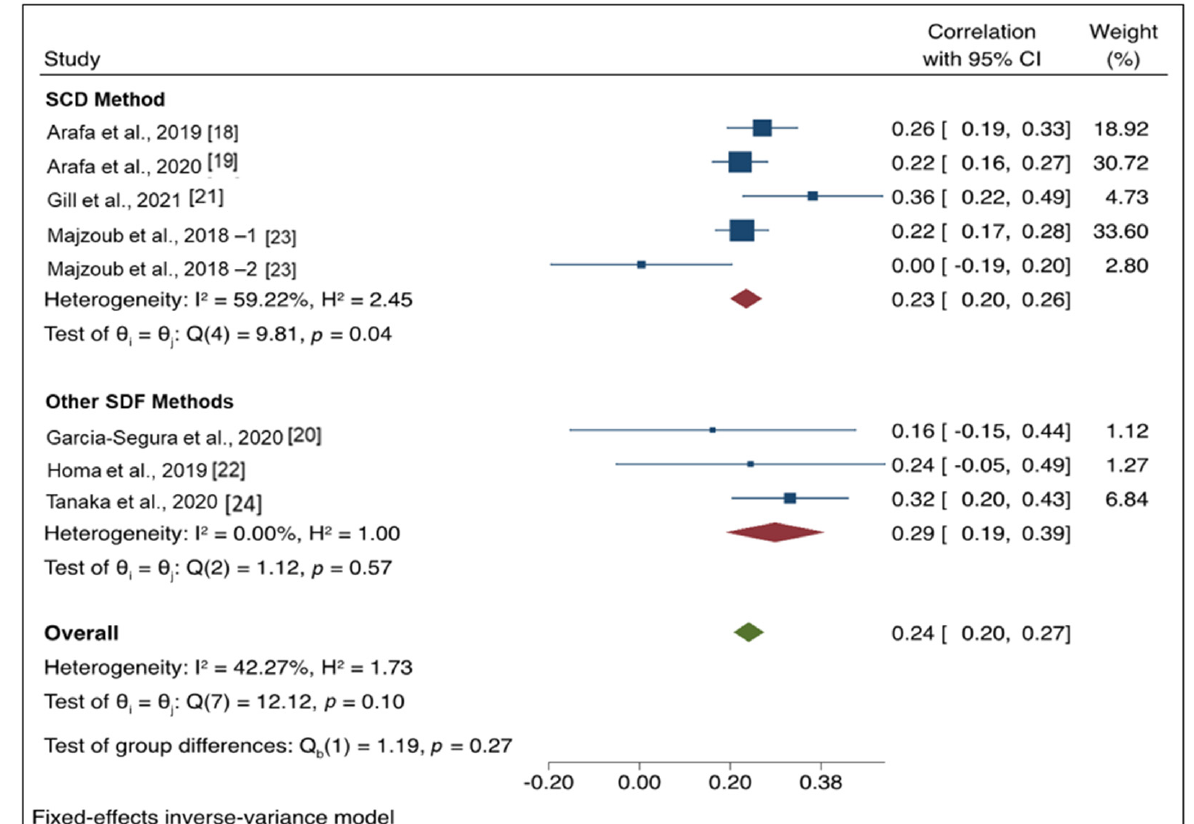
Figure 3. Forest plot for subgroup analysis of correlation coefficient between seminal oxidation- reduction potential and different sperm DNA fragmentation methods.